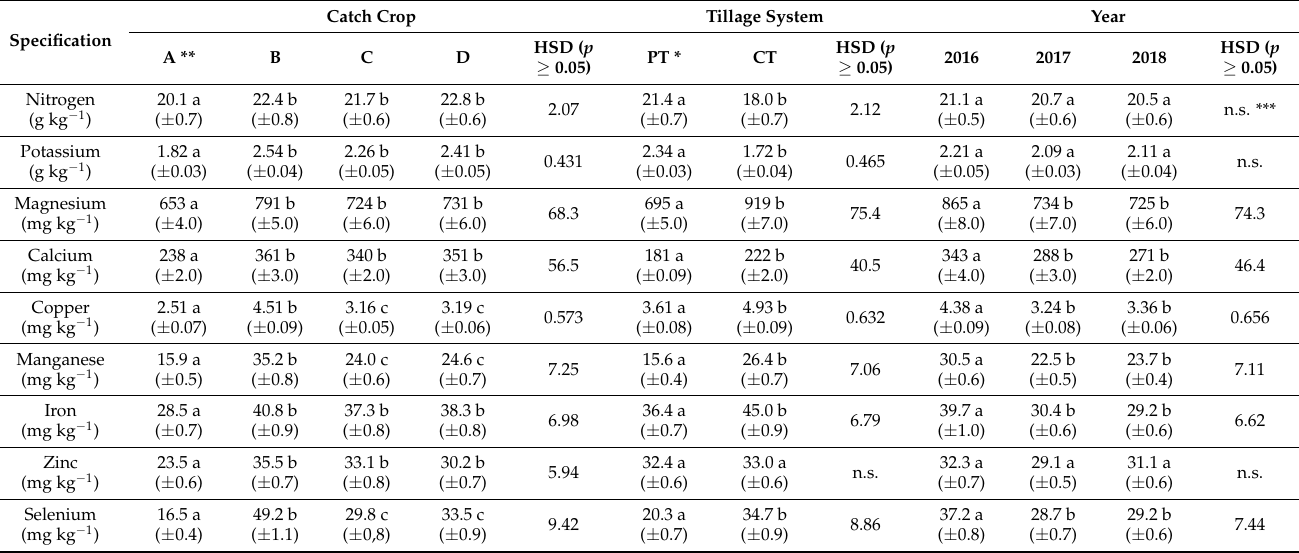
Table 10. Content of some macro- and micronutrients in spring wheat